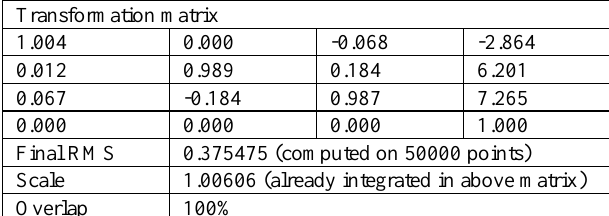
Table 2: Results from ICP fine